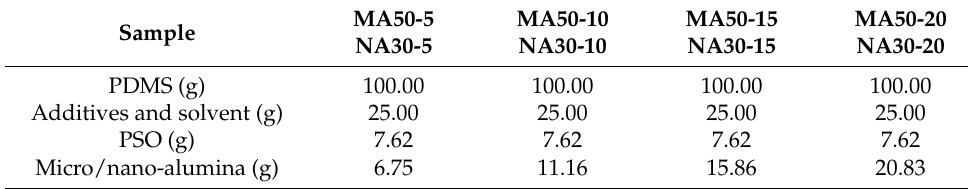
Table 1. Formulation of paints component A.